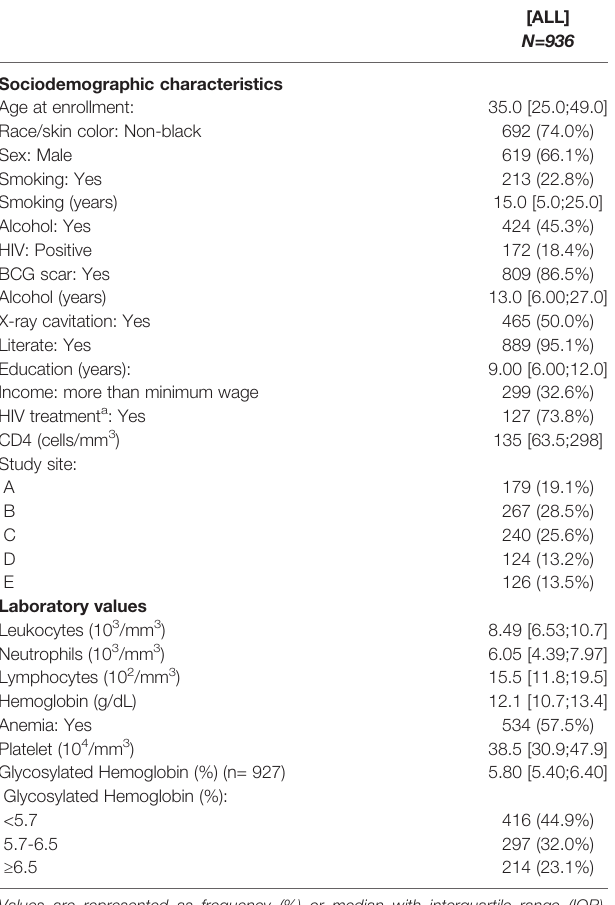
TABLE 1 | Sociodemographic characteristics and laboratory values for the study